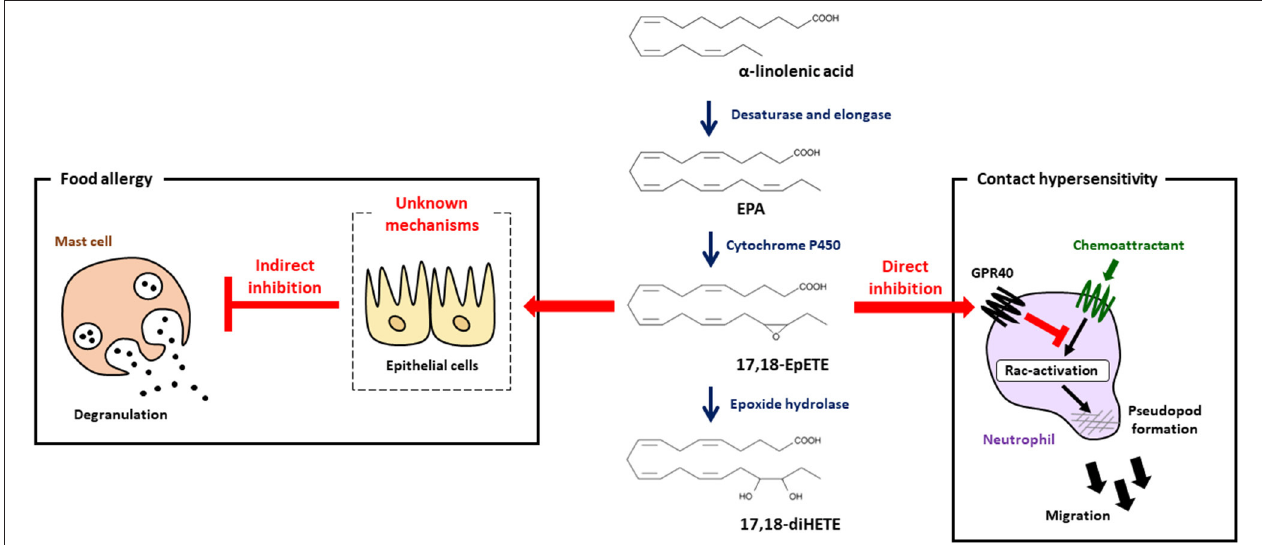
FIGURE 2 | 17,18-EpETE is a new class of anti-allergy and anti-inflammatory lipid mediator. 17,18-EpETE is produced by CYP from EPA. 17,18-EpETE suppresses contact hypersensitivity by reducing neutrophil infiltration into the skin by inhibiting Rac activation and migration through GPR40 signaling. 17,18-EpETE also indirectly inhibits the development of food allergy by inhibiting mast cell degranulation. Given that mast cells do not express GPR40, the detailed mechanisms responsible for this inhibition of mast cell degranulation remain unclear.